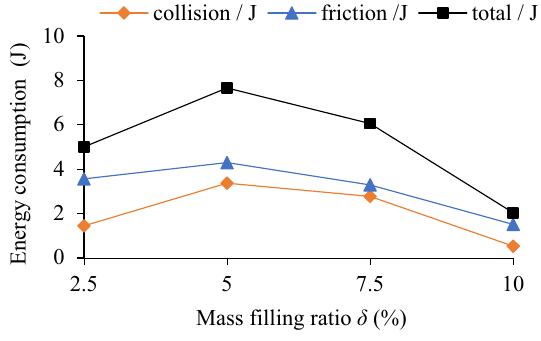
Figure 9. Influence of δ on TEC.